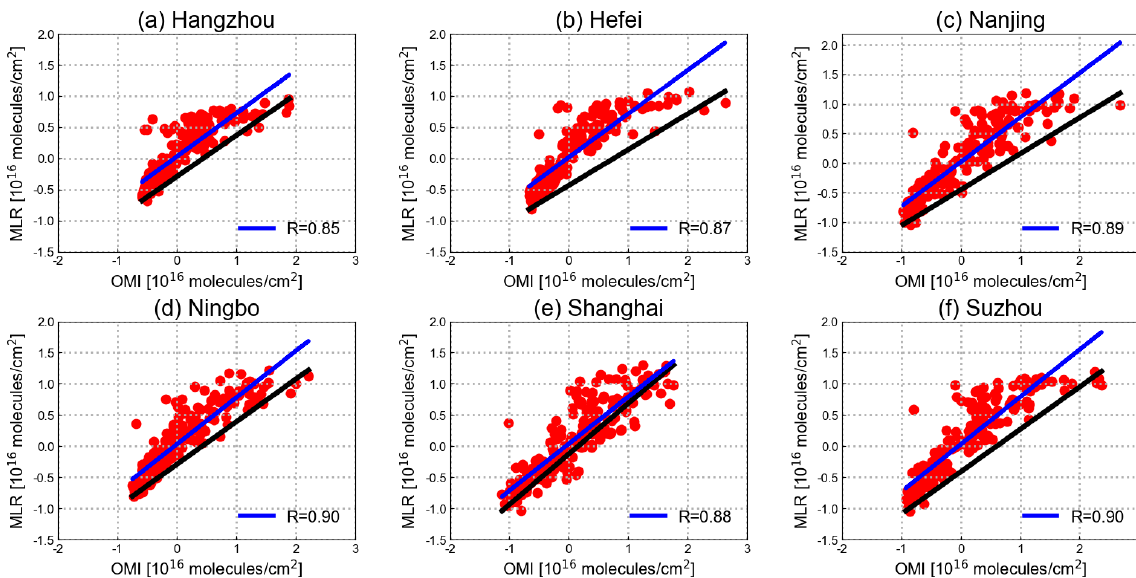
Figure 5. Correlations of OMI NO 2 VCD trop against the MLR model results over Hefei, Nanjing, Shanghai, Suzhou, Hangzhou, and Ningbo. Blue lines are linear fitted lines, and black lines are the 1:1 line.